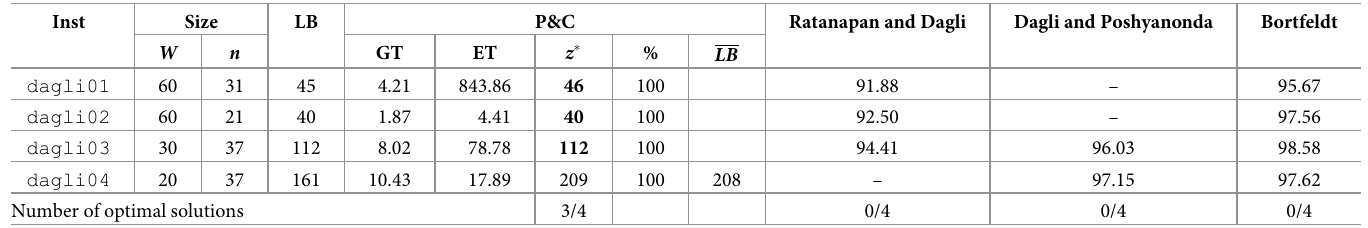
Table 3. Results for dagli